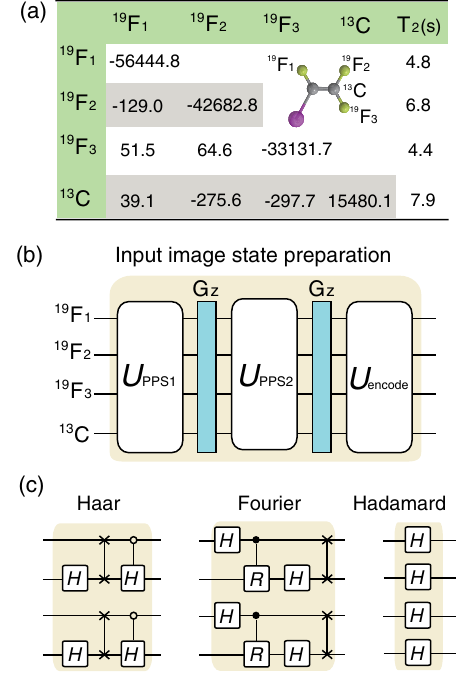
FIG. 3. (a) Properties of the iodotrifluoroethylene molecule. The chemical shifts and J -coupling constants (in Hz) are given by the diagonal and nondiagonal elements, respectively. The mea- sured spin-lattice relaxation times T 1 are 21 s for 13 C and 12.5 s for 19 F. The chemical shifts are given with respect to the reference frequencies of 100.62 MHz (carbon) and 376.48 MHz (fluorines). (b) Preparation of the input image states. Two unitary operators U and U and two z -axis gradient field pulses are used to PPS 1 PPS 2 prepare the pseudopure state (PPS) ρ 0000 . Then U realizes encode quantum image encoding. (c) Quantum circuits for the Haar wavelet, Fourier, and Hadamard image transforms, where H is a i is a phase Hadamard gate and R ¼